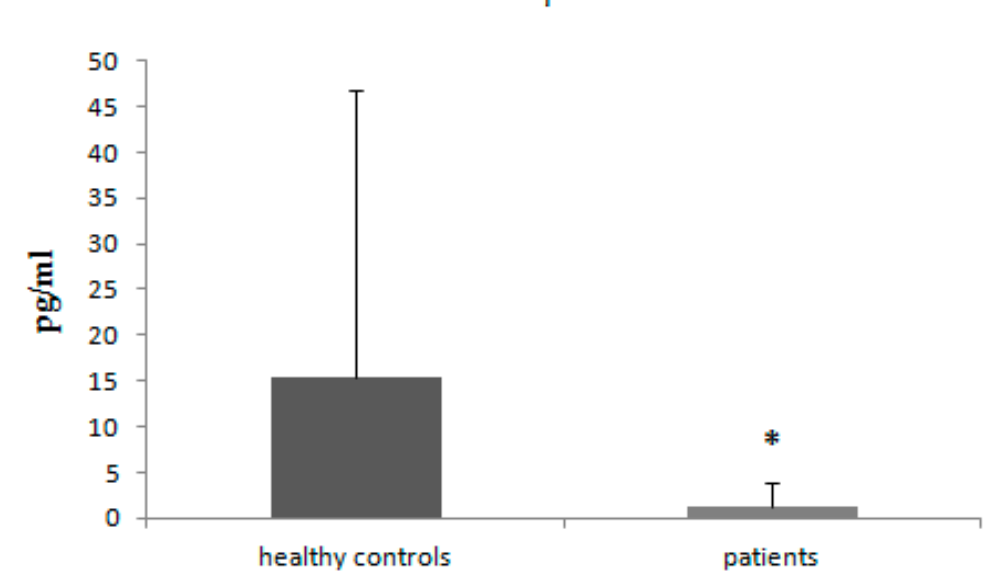
Figure 2. Plasma concentrations of IL-36 β in patients with psoriasis and control group. * p < 0.001.